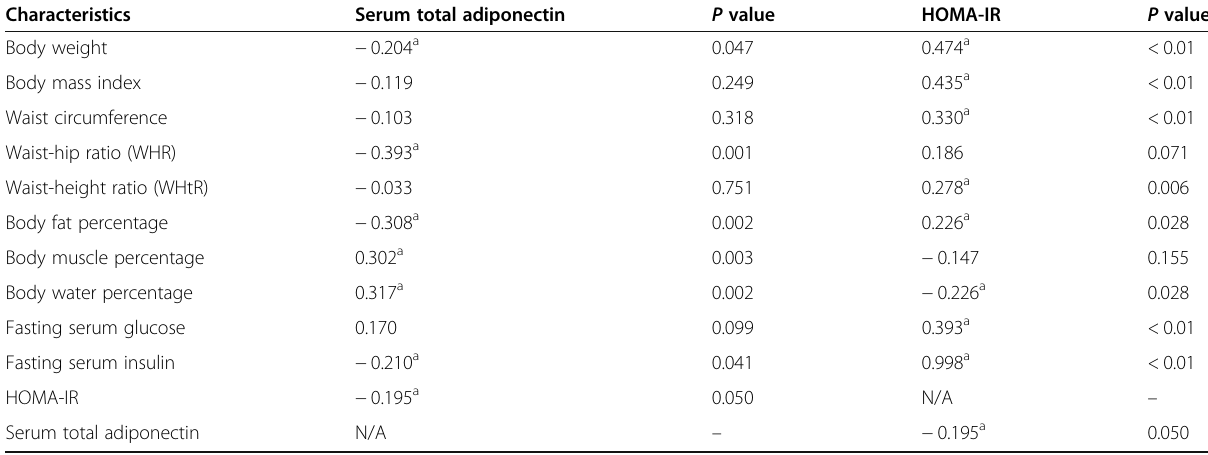
Table 2 Correlations of anthropometric and laboratory characteristics with serum total adiponectin and HOMA-IR before the intervention ( n = 95) Characteristics